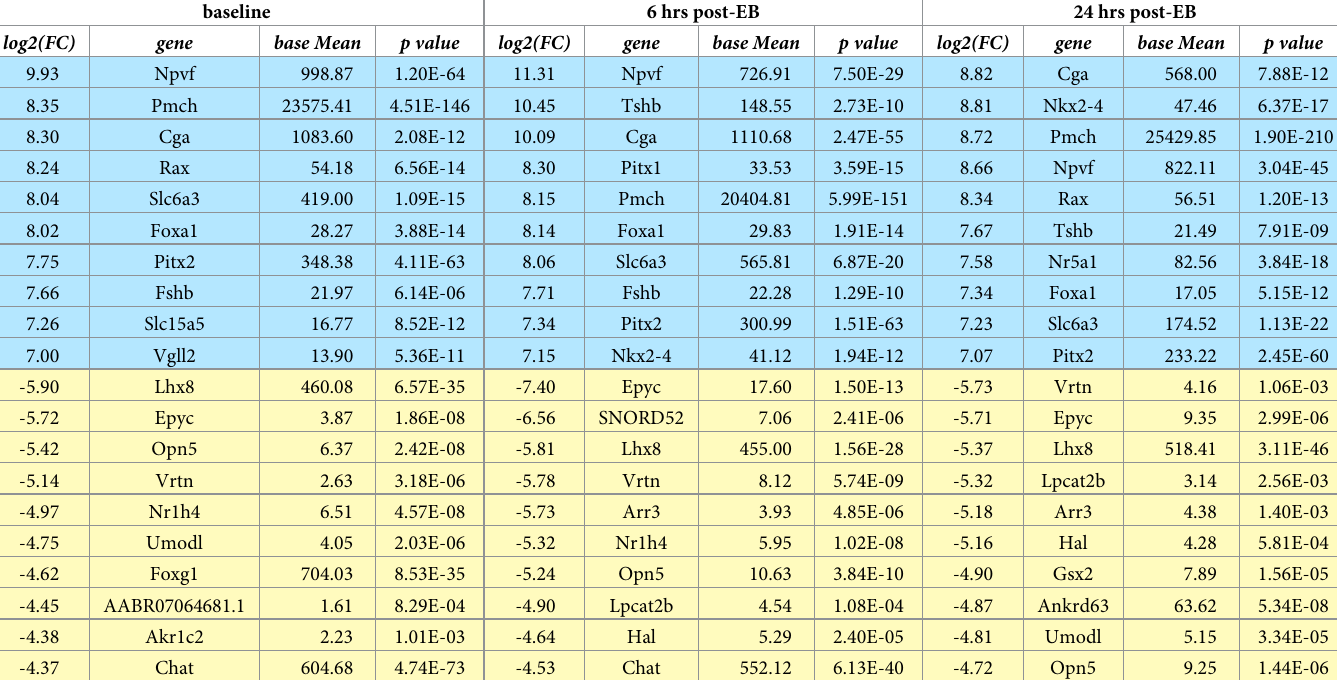
Table 1. Top DE genes between AVPV+ and ARH+ (positive FC = higher in ARH+, negative FC = higher in AVPV+).